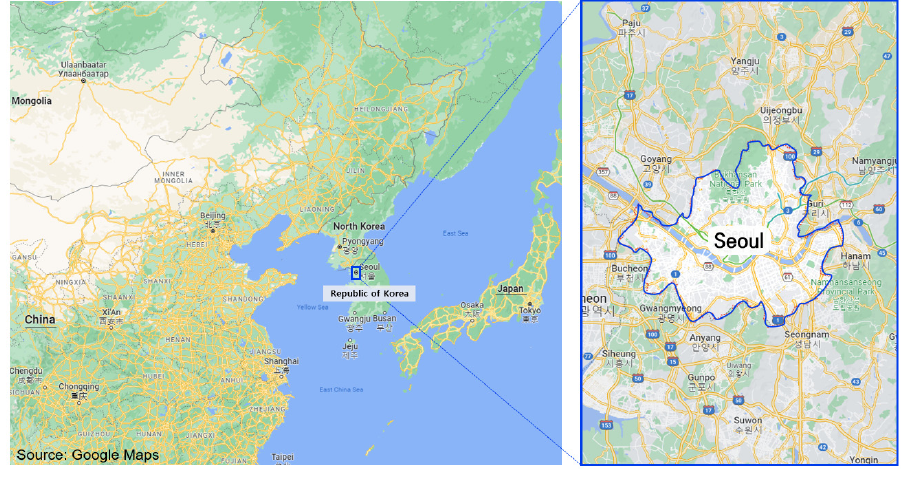
Figure 1. Study area.